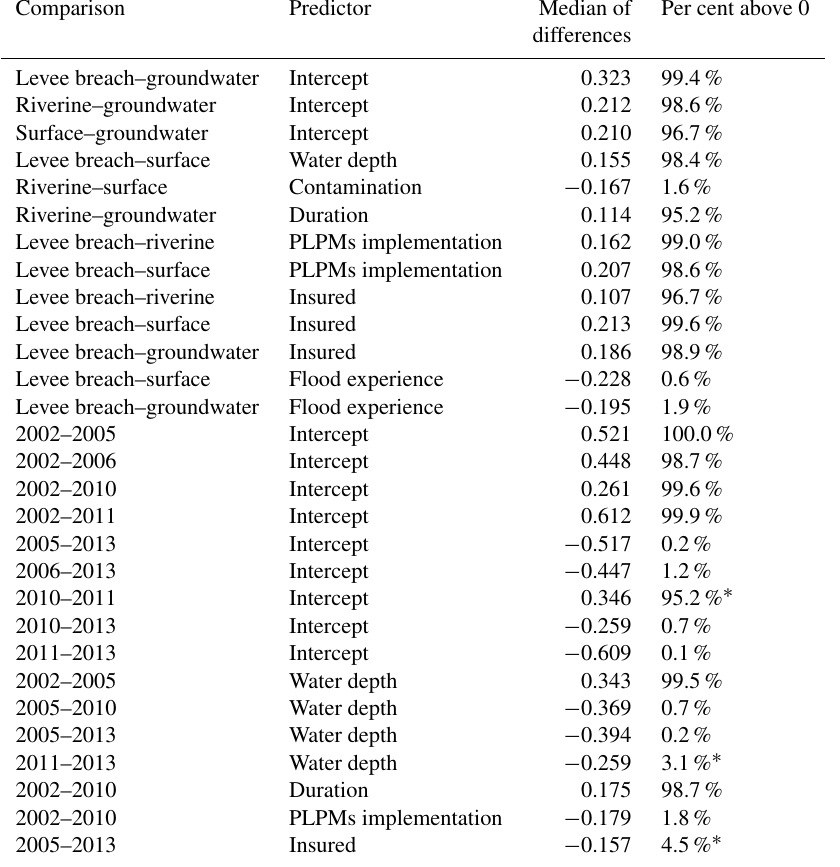
Table 7. Credibly different pairs of estimates with 95%